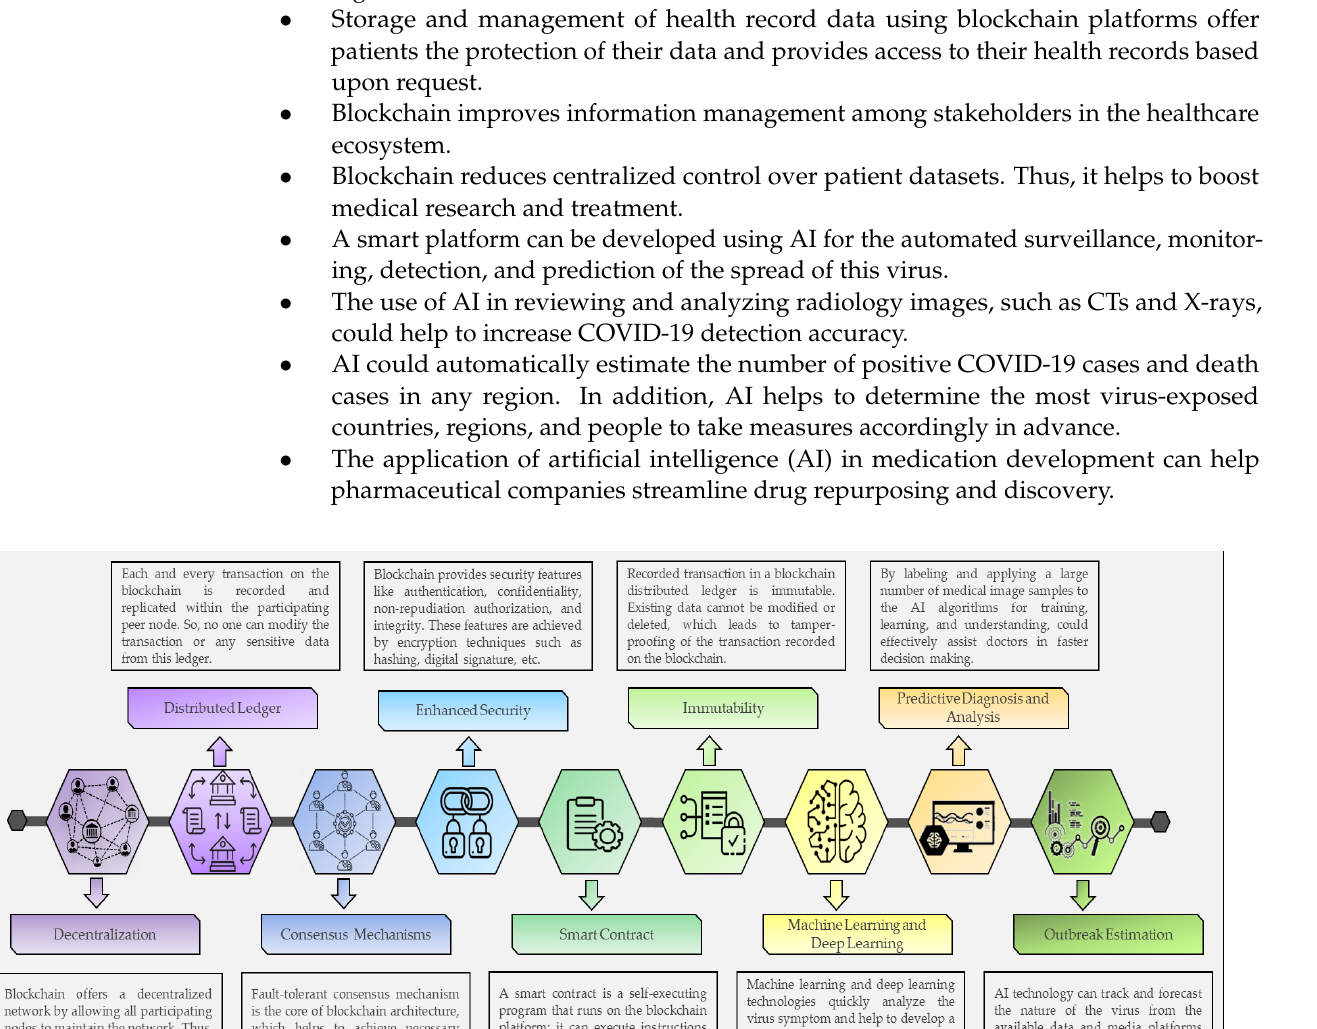
Figure 3. Schematic representation of the envisioned patient-centric framework using blockchain and AI technologies.